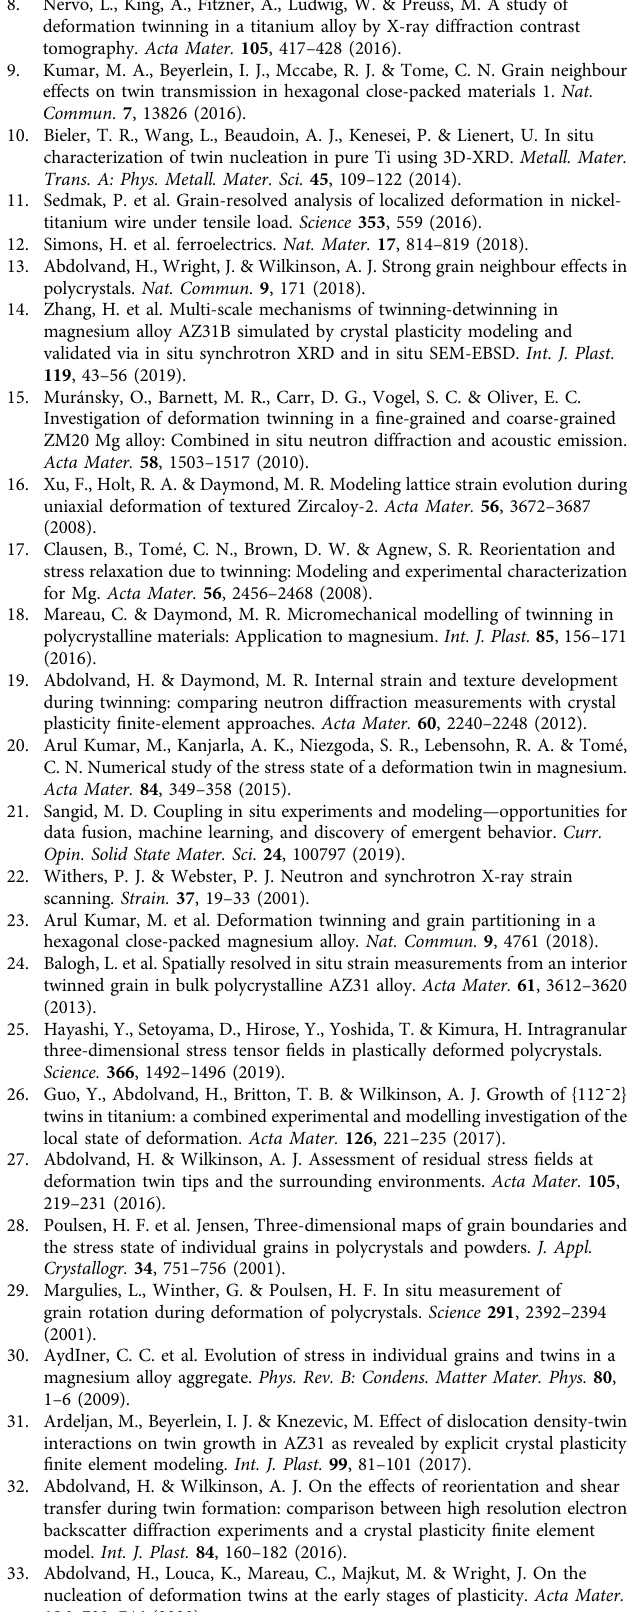
Table 3 Material parameters for the different deformation